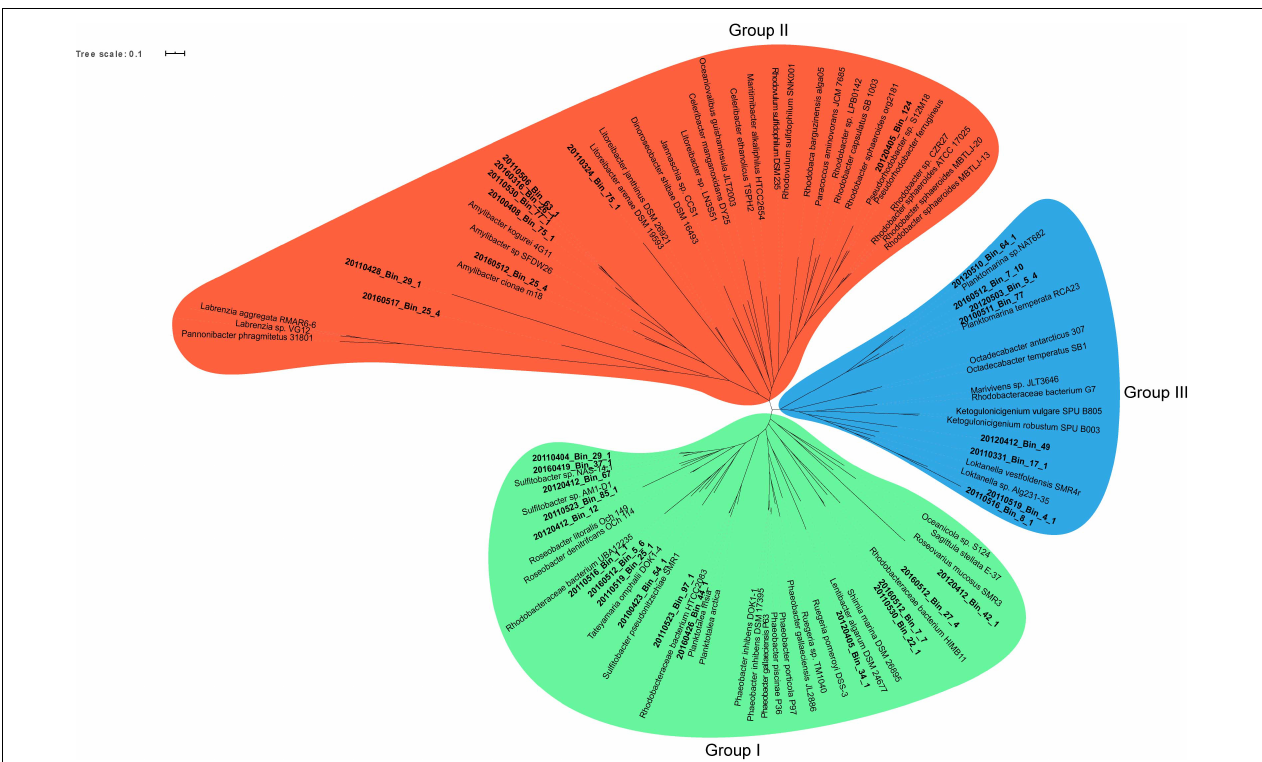
FIGURE 3 | Maximum likelihood unrooted phylogenomic tree of 107 conserved single copy genes from spring bloom associated Rhodobacterales MAGs (bold-faced) and publicly available Rhodobacterales genomes. Three branch points were identified and served as the basis for grouping the MAGs and genomes. Group I: Green, Group II: Red and Group III: Blue. The maximum likelihood phylogenomic tree was generated using RAxML and bootstrapping was performed at 100 iteration. Bootstrap values and sequence alignment can be found in the raw RAxML output file ( Supplementary File 2